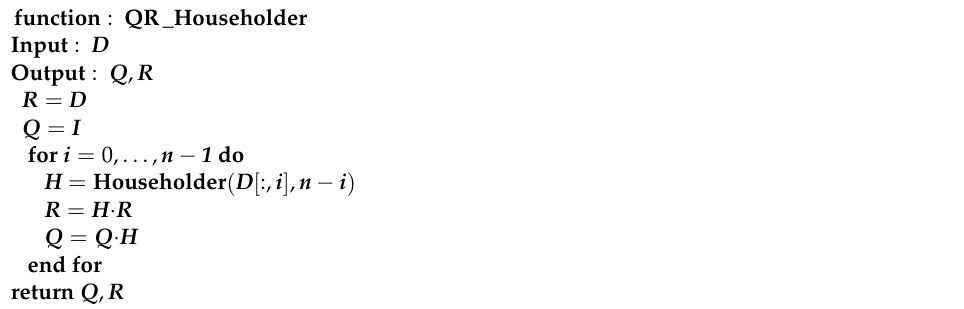
Table 7. The QR-Householder